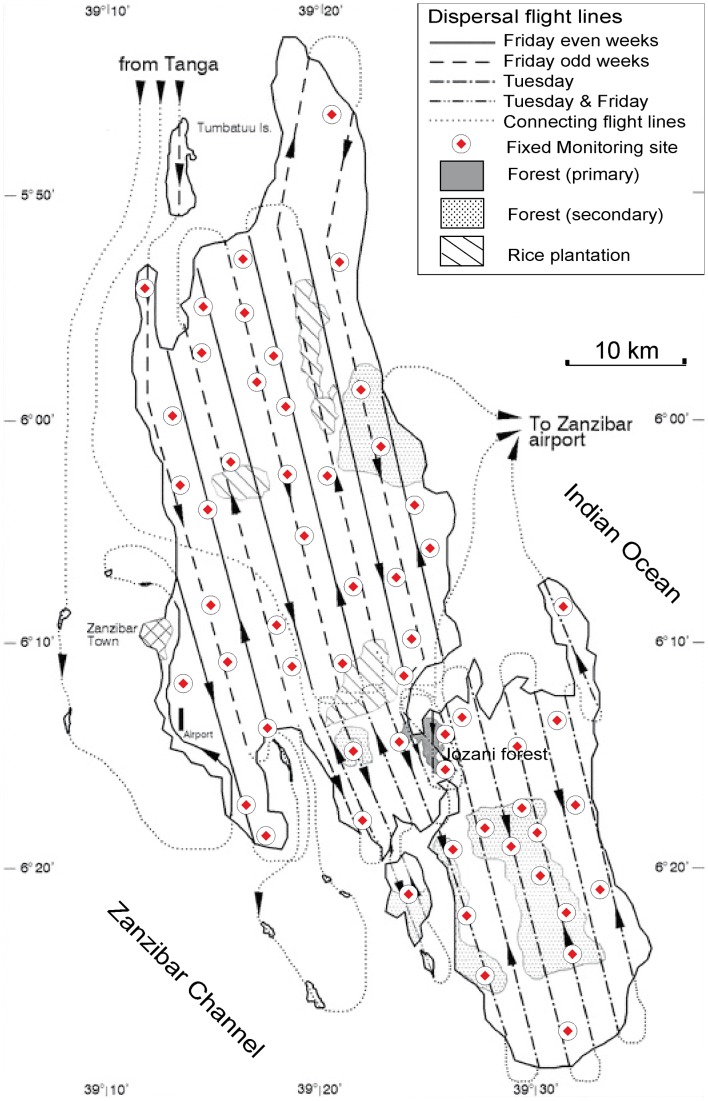
Flight lines and monitoring sites during the eradication campaign on the island of Unguja.The location of the 55 fixed monitoring sites is presented (red points).